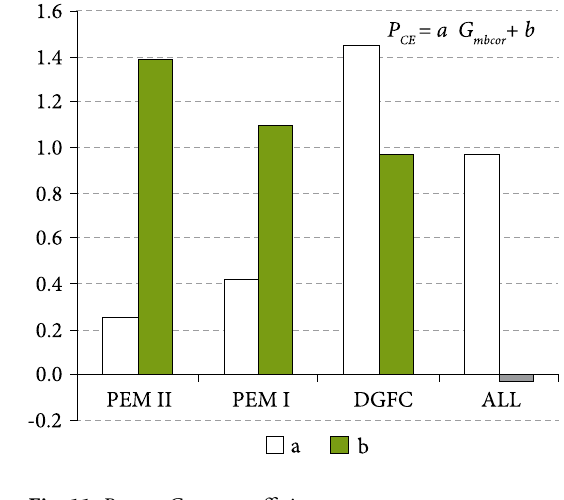
Fig. 10. P CE vs. W :